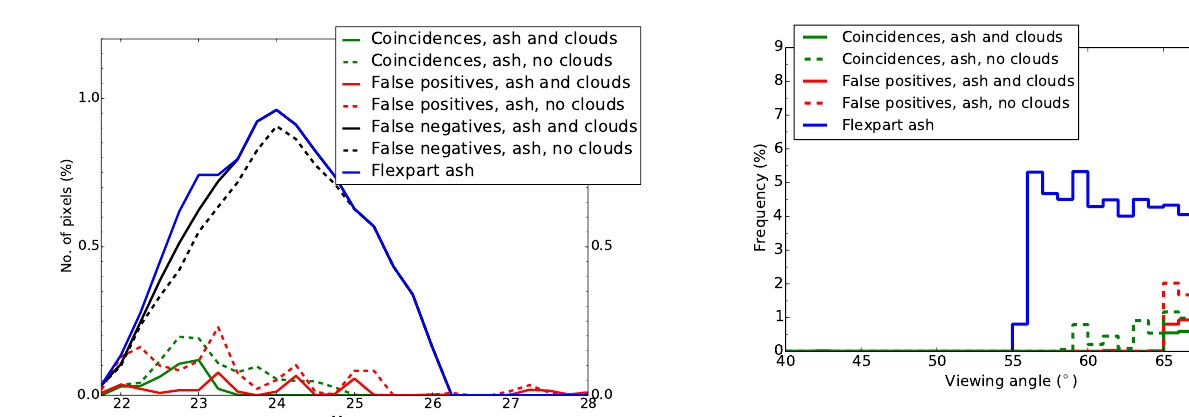
Figure 14. Similar to Fig. 9, but for the Grímsvötn (2011) eruption. The frequency of pixels identified as ash in the Flexpart simulations (blue line), false positive pixels from ash detection (red line) and coincidences (green line) are shown. Solid (dashed) lines represent cloudy (cloudless)